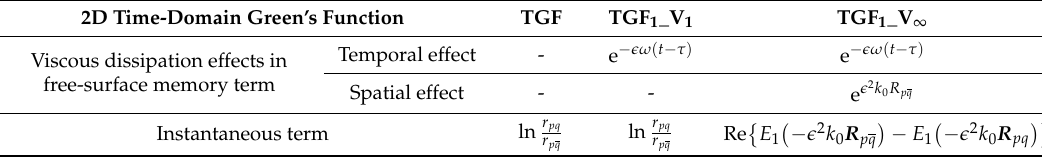
Table 1. Comparison of newly developed 2D time-domain Green’s functions TGF 1 _V ∞ with TGF 1 _V 1 and conventional Green’s functions TGF. The TGF 1 _V n ( n = 1, ∞ ) are derived from a “fairly perfect fluid” model [1]. In TGF 1 _V 1 only the first order viscous dissipation effects are exactly considered, while in TGF 1 _V ∞ all order viscous dissipation effects are fully considered. The exact viscous dissipation effects in TGF 1 _V ∞ appear not only in the free-surface memory term of the Green’s function, but also in the instantaneous term. (cid:101) is the non-dimensional viscosity coefficient, E 1 ( · ) the complex exponential integral